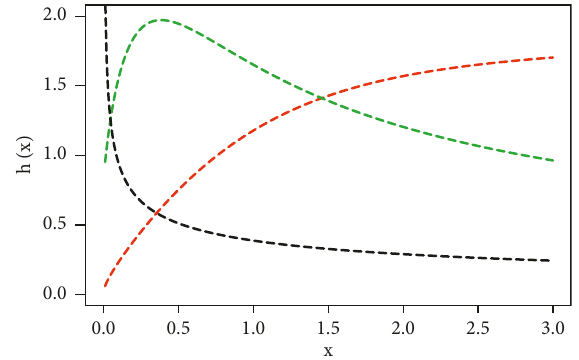
Figure 2: Visual display of f ( x ; δ , λ ) . Figure 3: Visual display of h ( x ; δ , λ )